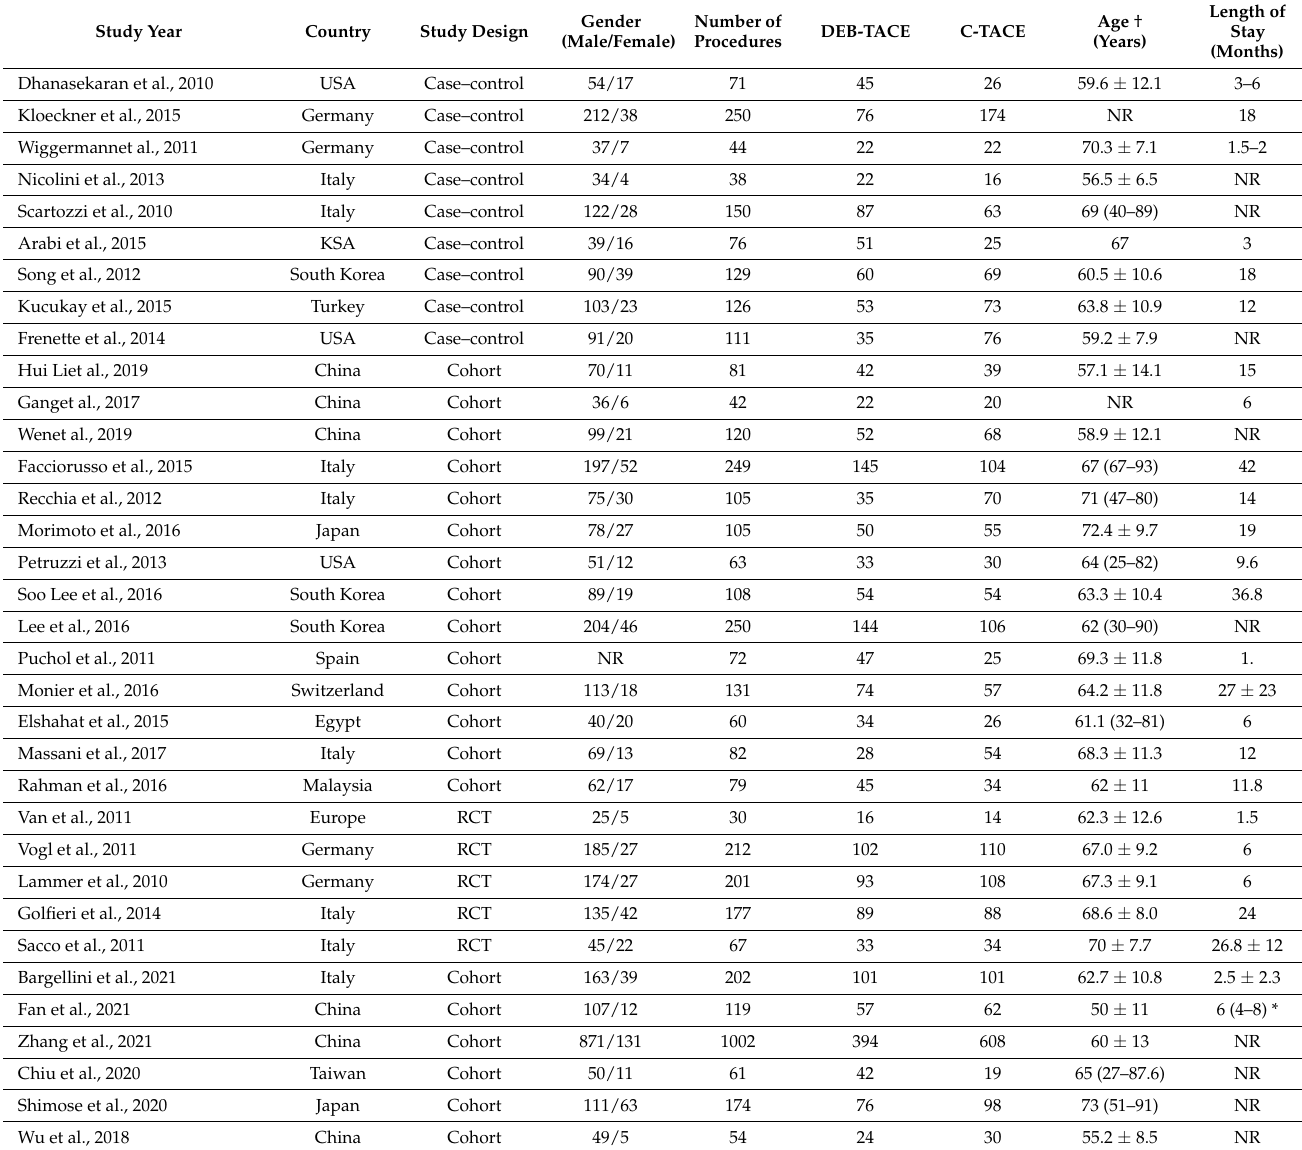
Table 1. Study characteristics of included